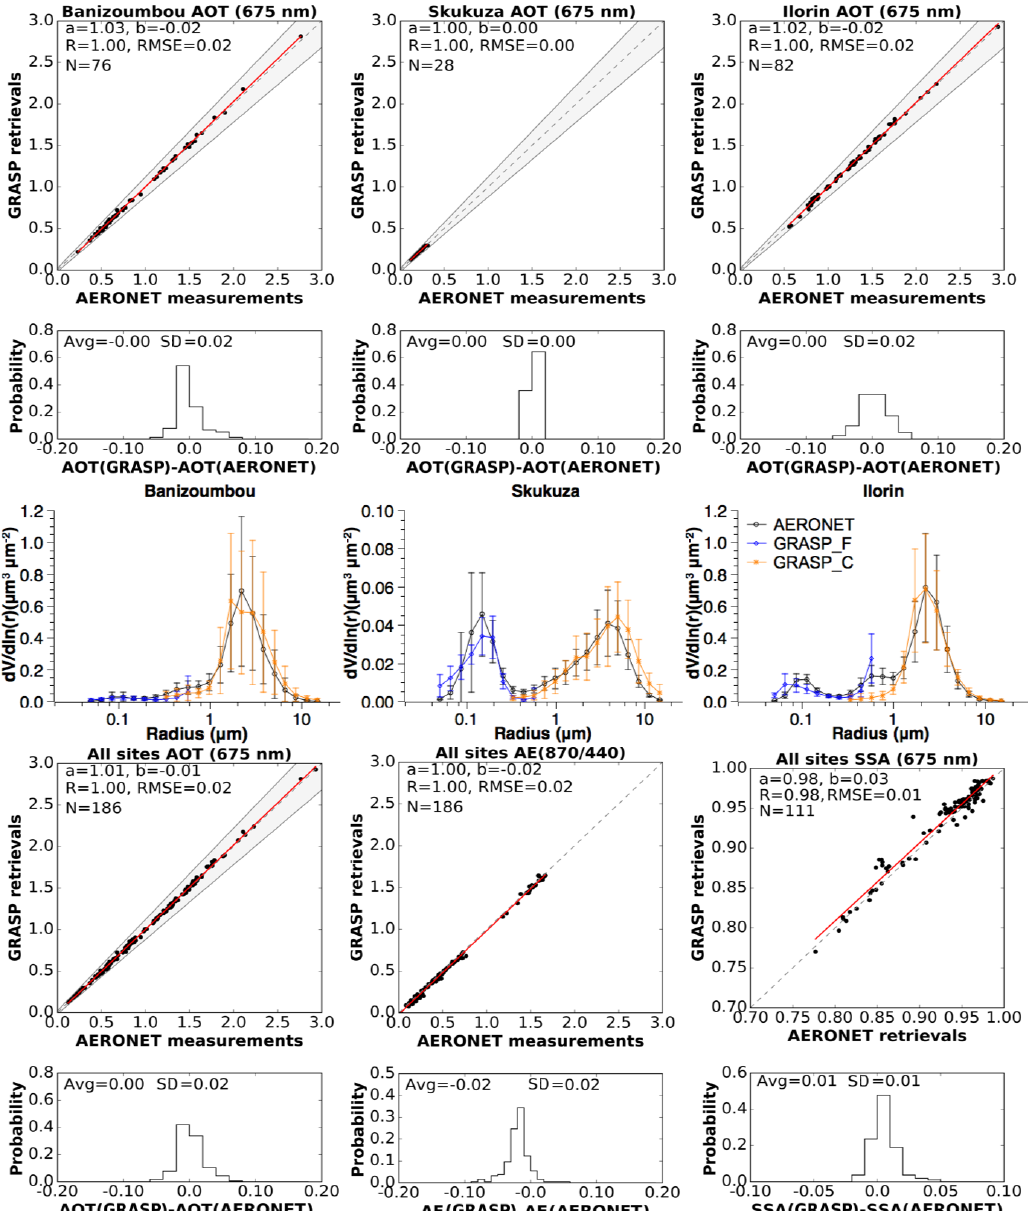
Figure 9. The intercomparison of aerosol optical properties derived from sun/sky photometer measurements using the GRASP/Component approach with the corresponding values of the AERONET operational product. The data presented for the Banizoumbou site in April 2007 represent mineral dust aerosol, the data for the Skukuza site in September 2007 represent the biomass burning aerosol, and the data for the Ilorin site in January 2007 represent the mixture of dust and biomass